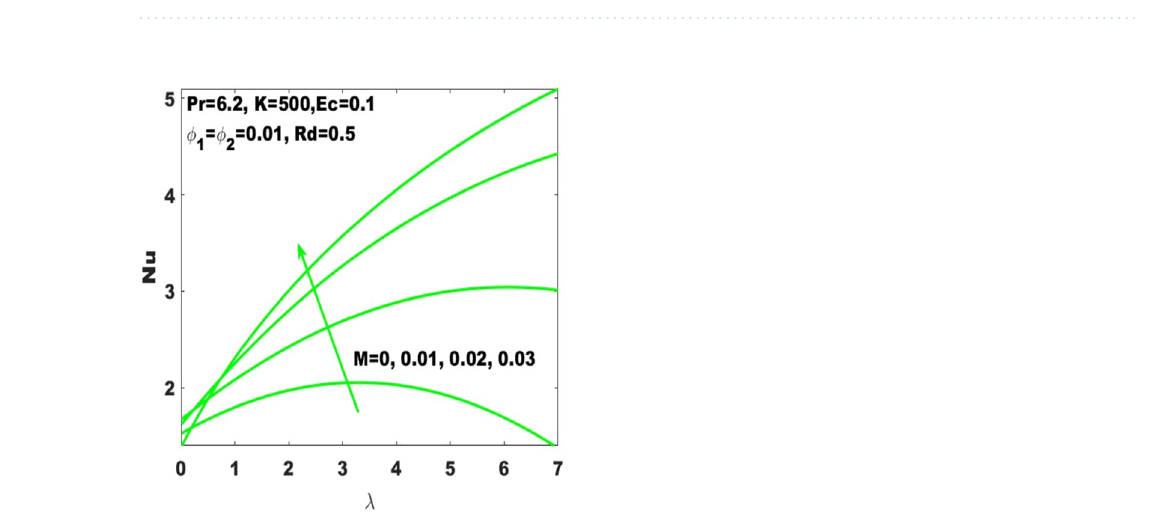
Figure 3. Change in Nu with (cid:31) for diverse values of M .